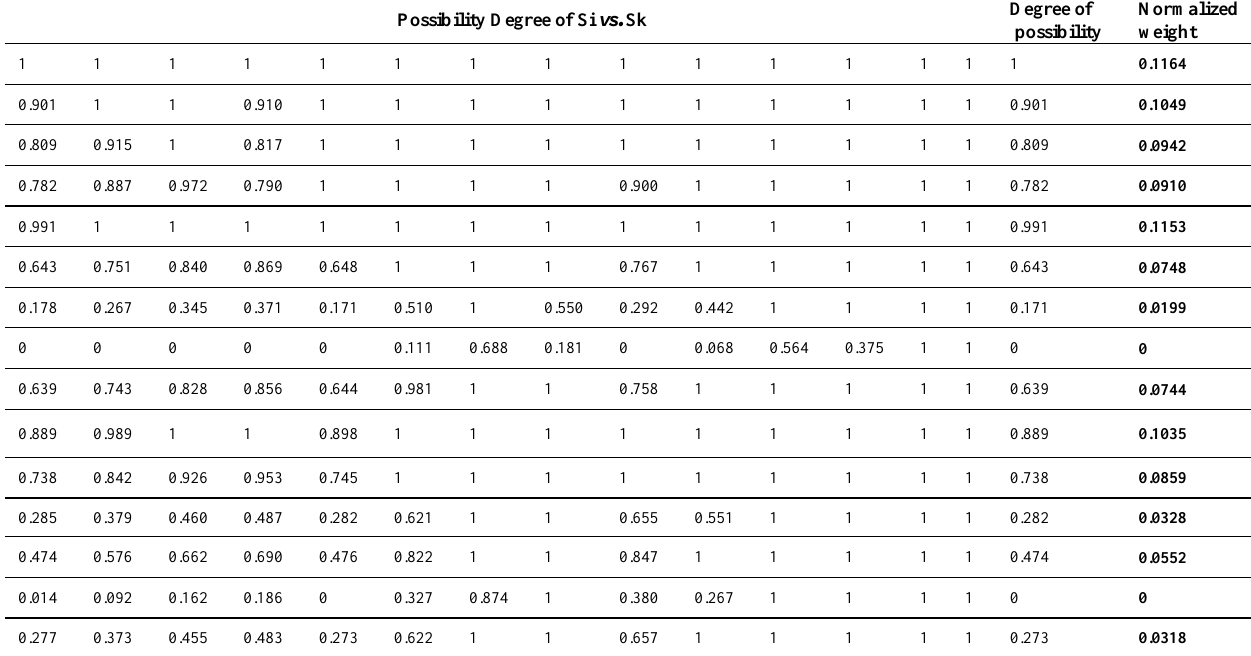
Table 11. Normalized weight calculation.